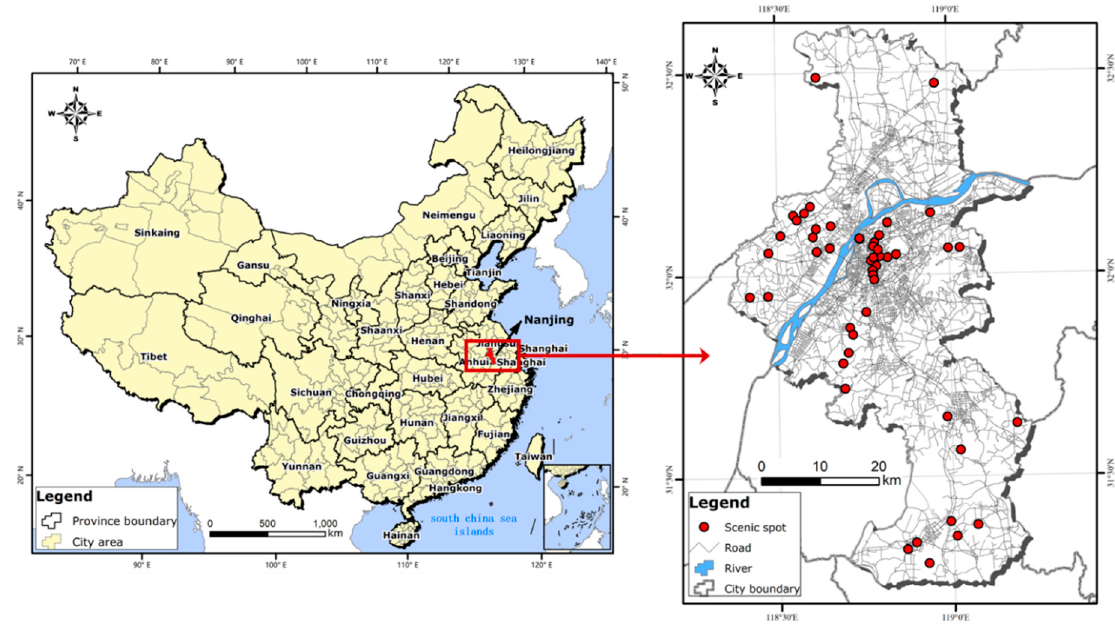
Figure 1. Study area (all cities of mainland China and all scenic spots in Nanjing).